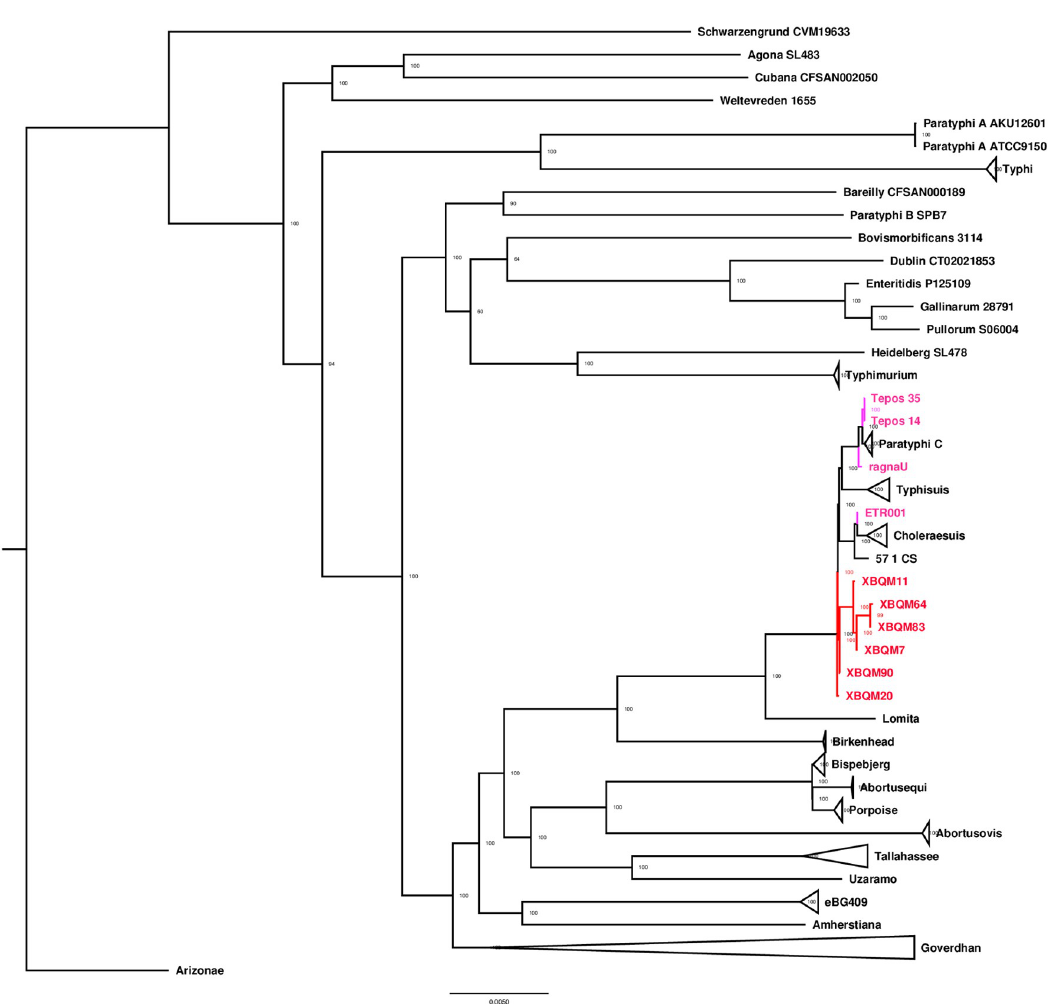
Fig 3. Phylogenetic relationships of the ancient and modern Salmonella enterica . A maximum likelihood tree was generated with 1000 replicates. Part of modern genomes are collapsed based on their predicted serovar in order to better representation of the relevant information, Arizonae strain is used as the outgroup. Ancient genomes reported in this study are shown in red, and previously reported ancient genomes (Tepos35, Tepos14, ragnaU and ETR001) in pink. Most of ancient XBQ genomes form a unique branch basal to the Para C